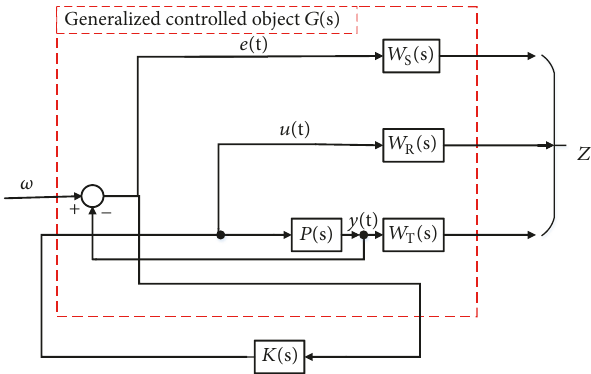
Figure 3: Block diagram of hybrid sensitivity design of EPS